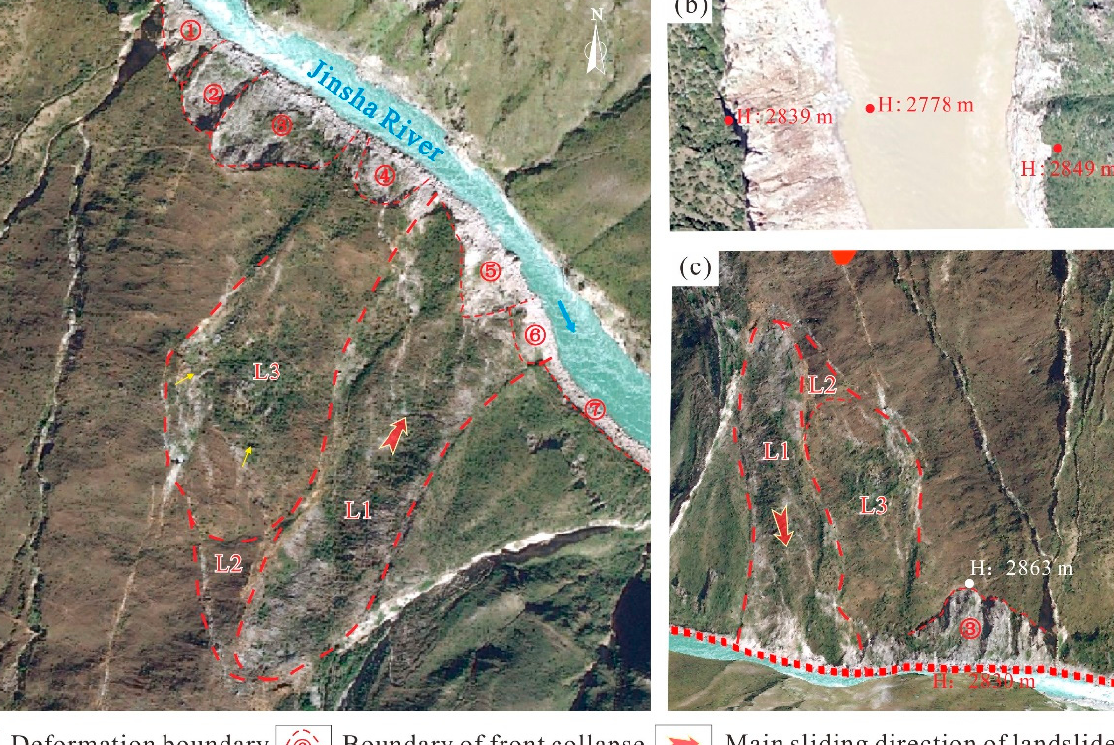
Figure 10. Remote sensing image of the field survey in the revival area of the front edge of the Xiongba ancient landslide. ( a ) Deformation characteristics of the H 1 front edge (based on UAV images); ( b ) erosion characteristics of rivers in the H 2 front; ( c ) three-dimensional image of deformation characteristics of H 1 front.